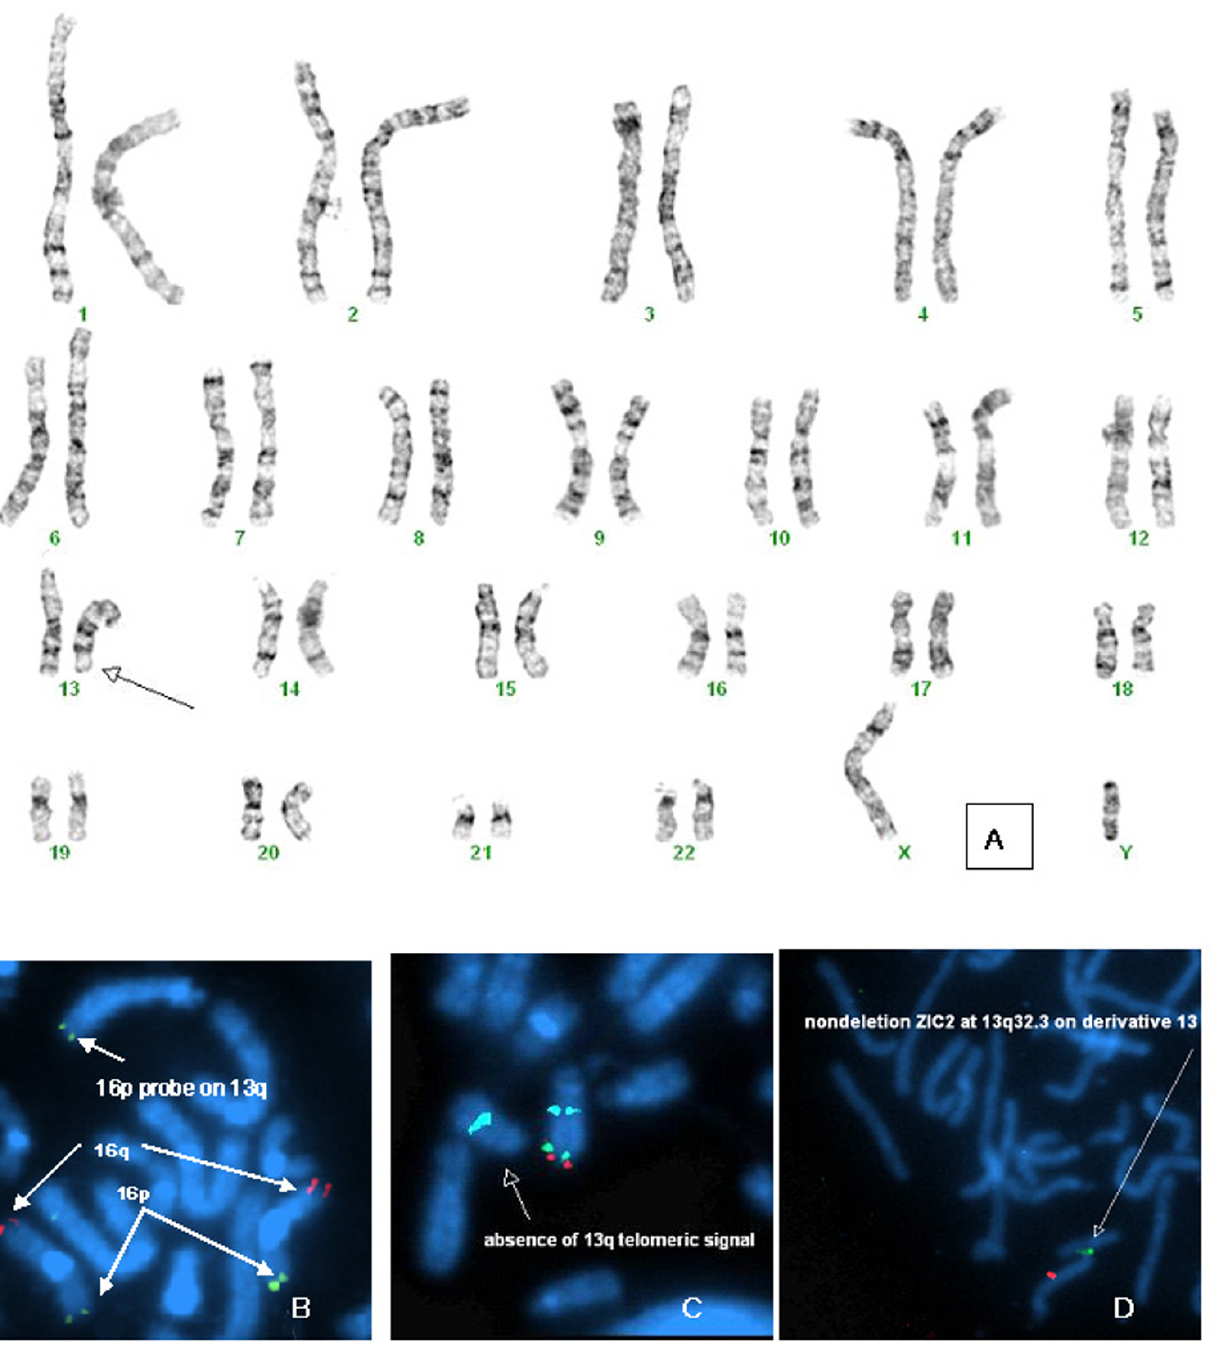
Figure 2 Routine cytogenetics identified a translocation of material of unknown origin onto 13q33 (panel A). Using probes specific for subtelomeric sequences, a translocation was identified from 16p (green) onto 13q (panel B, red probe is for 16q). Similarly, two probes for distal 13q (red and green probes, panel C) were absent from one chromosome 13 identified using an aqua- labeled proximal 13q probe. A FISH BAC probe specific for the ZIC2 gene on 13q (panel D, green probe) confirms that it is not deleted in this